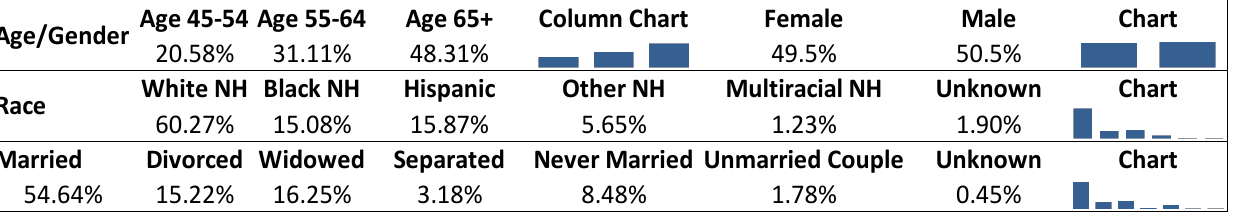
Figure 2. Plot of weighted diabetes management variables over time.